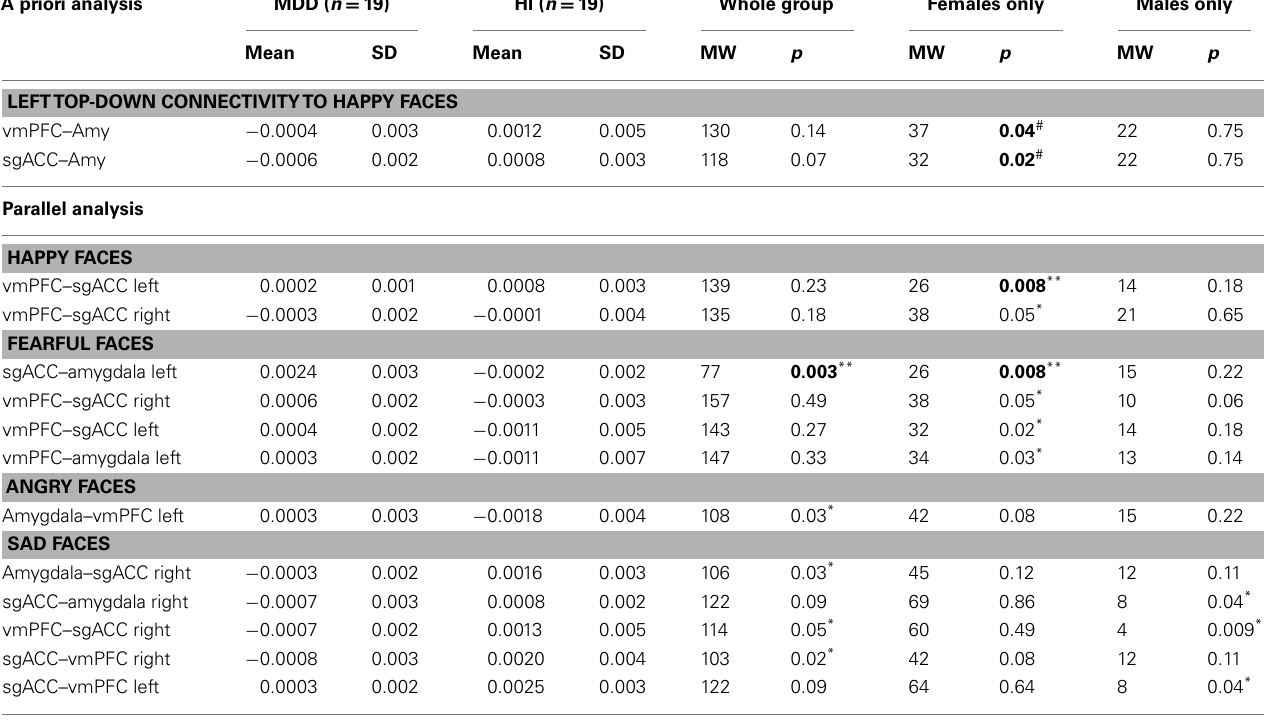
Table 2 | Effective connectivity estimates in a priori and parallel analysis to happy, angry, sad, and fearful faces. A priori analysis